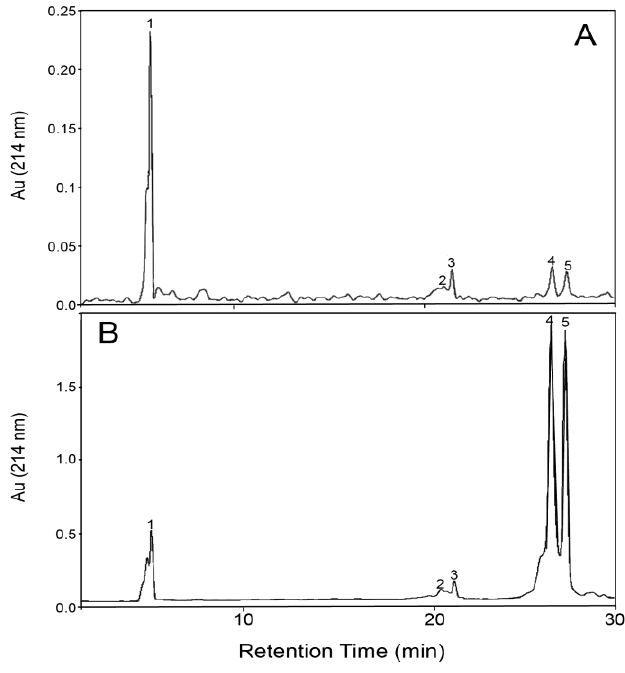
Figure 3. RP-HPLC chromatograms: ( A ) enriched GMP fraction (filtrate, 58% GMP) and ( B ) enriched β-LG fraction (retentate, 84% β-LG) after treatment of a 10% WPI solution with SCO at 65 °C and pH 4.6, ultrafiltration with 30-kDa membrane and two washes. 2 Peaks assignment: 1, GMP (3.7–4.0 min); 2,3, α-LA (19.2–20.6 min); 4,5, β-LG (25–27